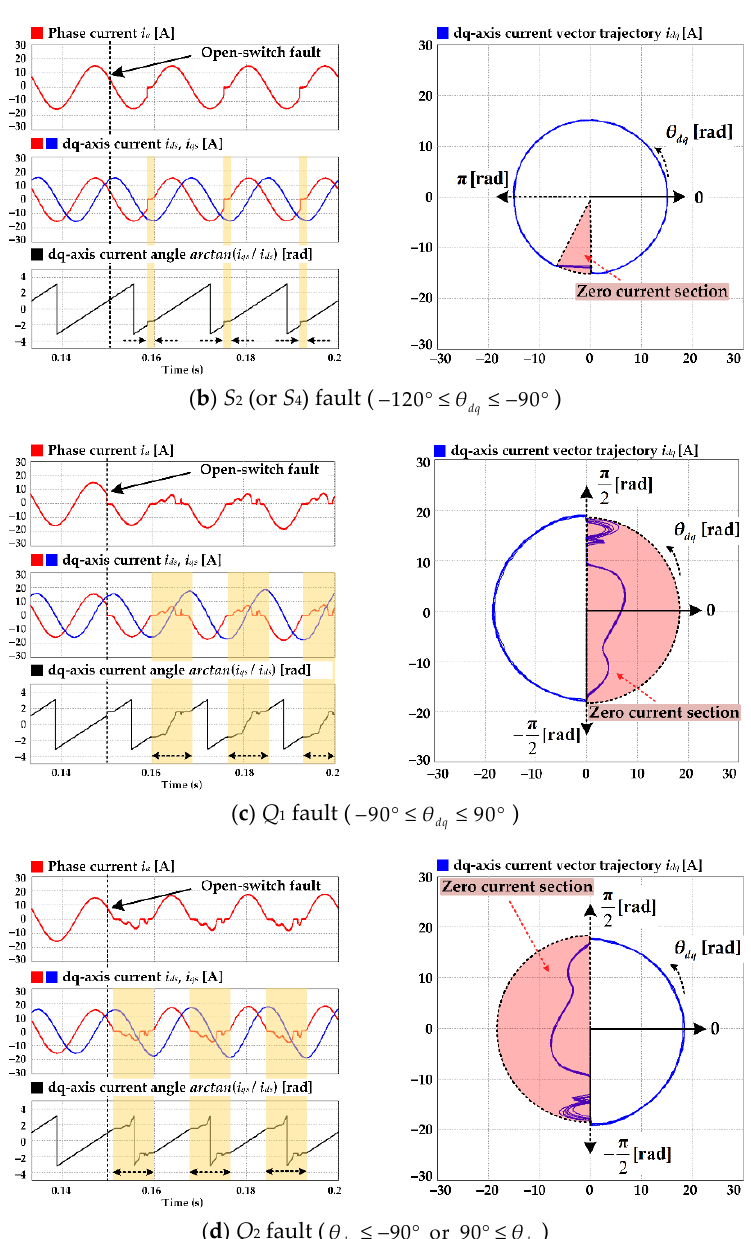
Figure 9. Faulty phase current, dq-axis current and current vector angle waveforms for zero current section under A-phase single switch fault in the HANPC rectifier (PF = 3 2 − ).